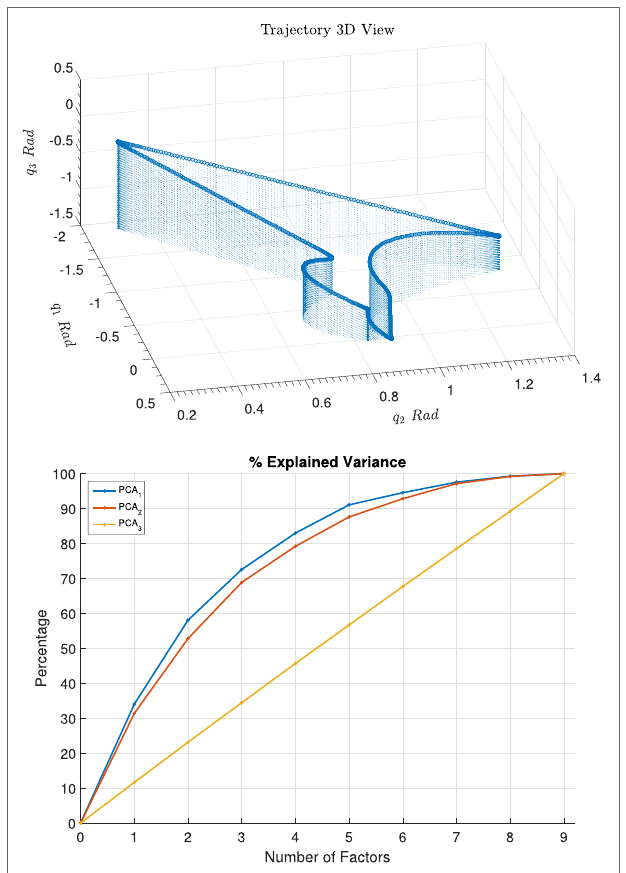
FIGURE 4 | PCA results comparison between input ( PCA 1 ), lack-of-fit residuals ( PCA 2 ) and a random signal ( PCA 3 ) for move–stop–move trajectory.